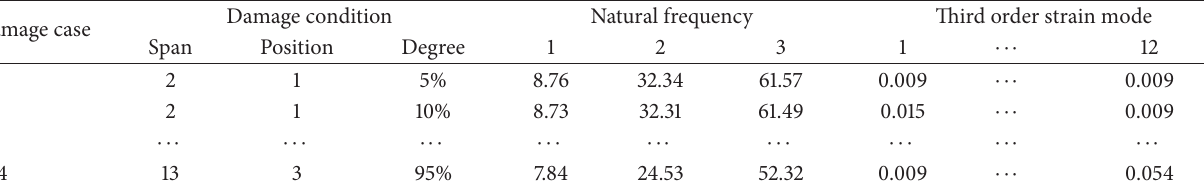
Table 5: Minimum property set 3 after reduction.